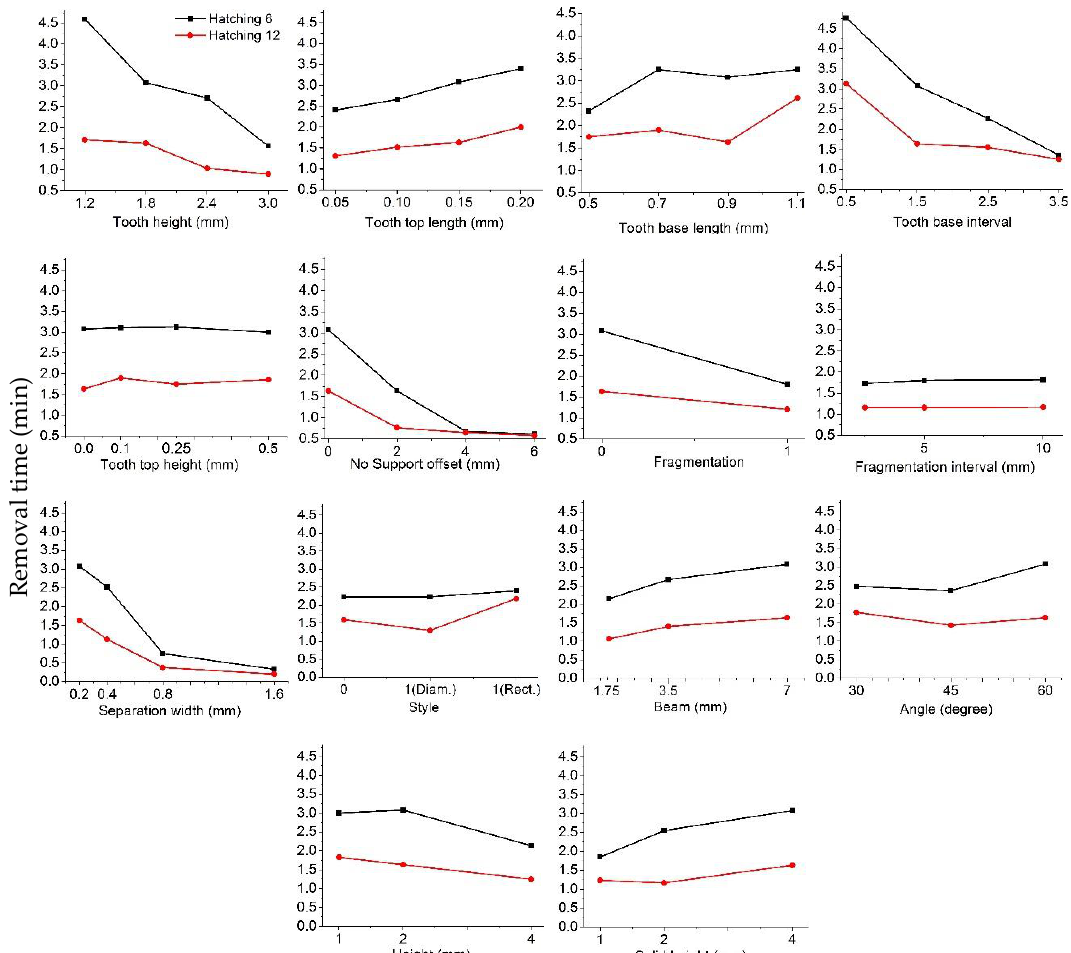
Figure 7. E ff ect of support design parameters on support removability. Figure 7. Effect of support design parameters on support removability.